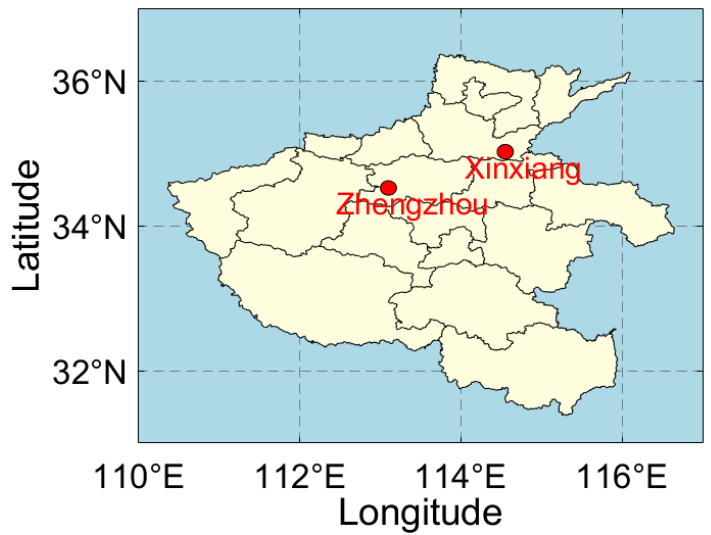
Figure 3. Latitude and longitude of the two floods. The map denotes Henan Province, China.